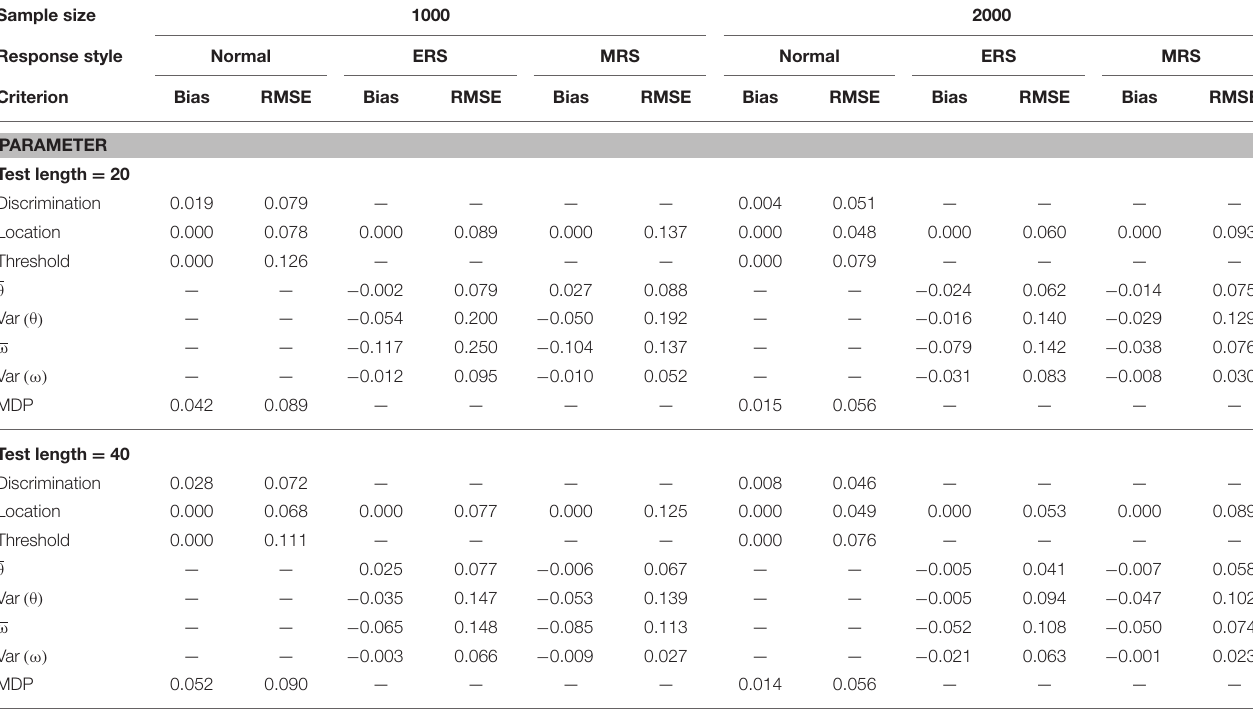
TABLE 4 | Mean bias and RMSE of the model parameter estimates for the mixture ERS-GPCM-CD on 6-point items. Sample